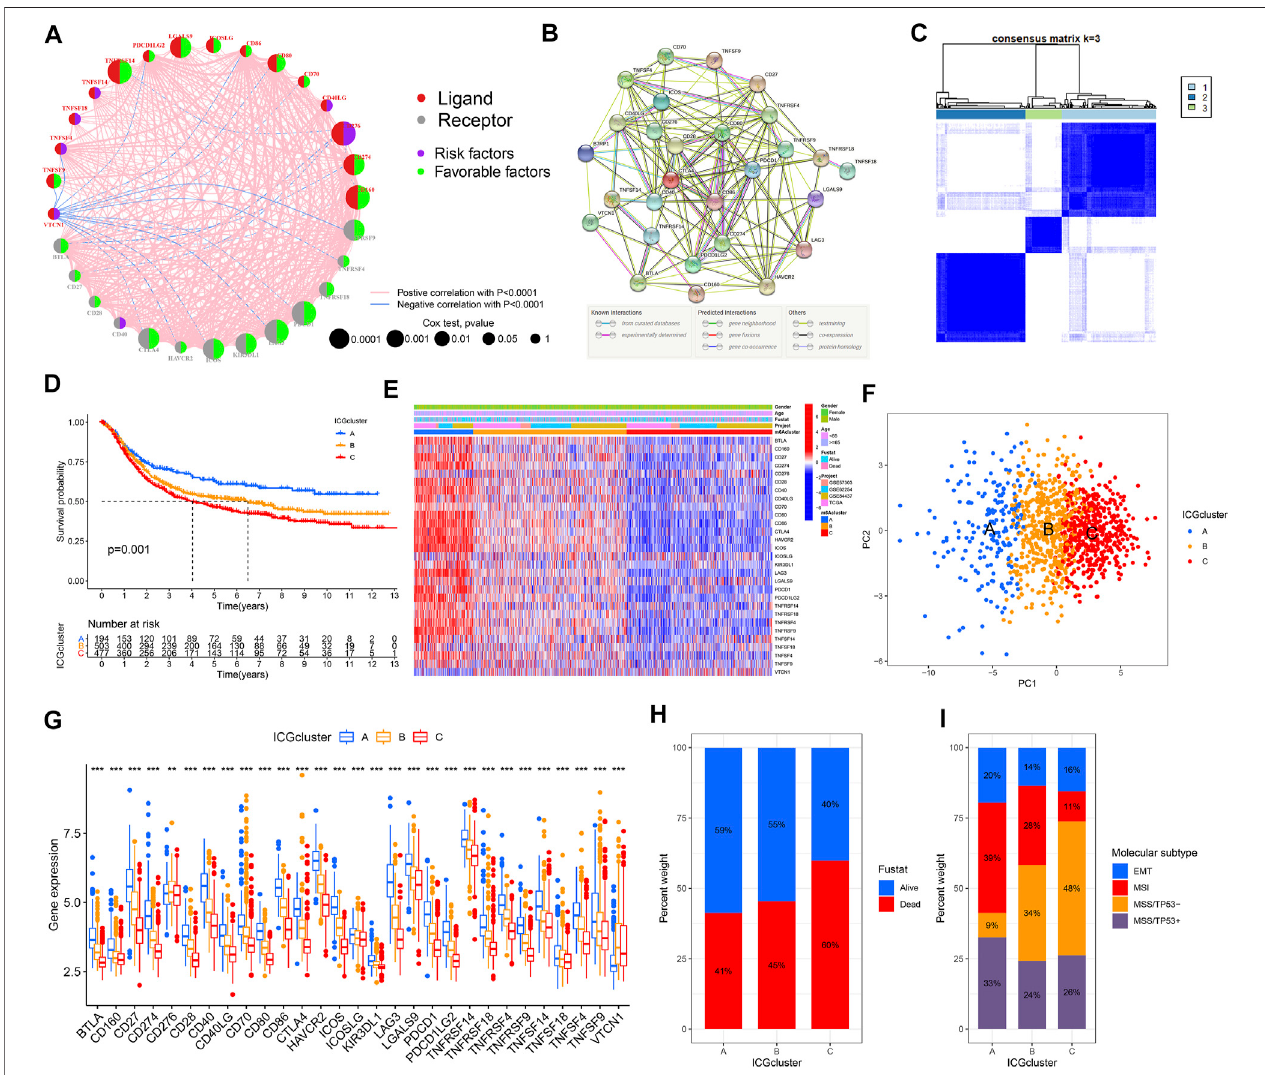
FIGURE 2 | Establishment of the immune checkpoint patterns mediated by 31 ICGs. (A) The interaction between ICGs in GC and corresponding prognostic signi fi cance. (B) The protein-protein interaction networkof ICGs using the STRING. (C) Consistentclustering matrices based on 31 ICGs for k = 3. (D) Survival analyses for the three immune checkpoint patterns based on 1174 GC patients. (E) The heatmap of 31 ICGs expression using unsupervised clustering. (F) Principal component analysisforthetranscriptomepro fi les ofthreeimmunecheckpoint patterns, showingaremarkabledifferenceon transcriptomebetweendifferentpatterns. (G) The expression of 31 ICGs in three clusters. (H) The proportion of survival status in the three patterns. (I) The proportion of molecular subtypes of the GSE62254 cohort in each pattern.